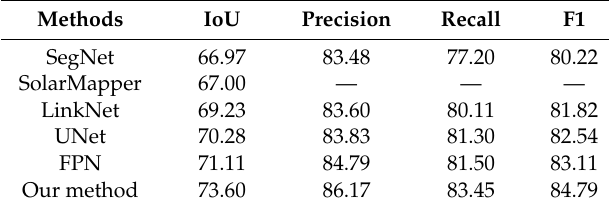
Table 3. Accuracy of each method on the Duke California Solar Array data set